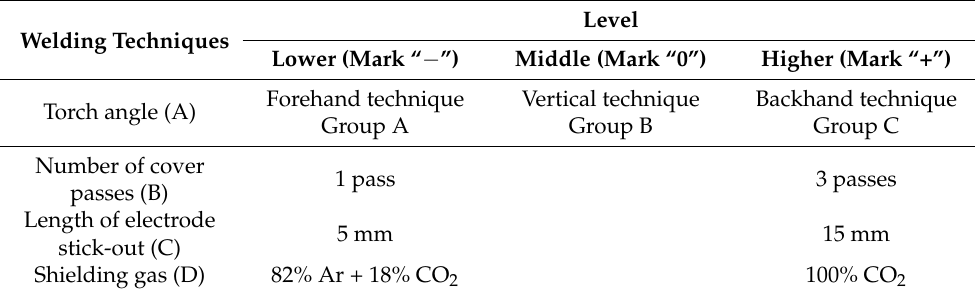
Table 2. Welding techniques used in the study.